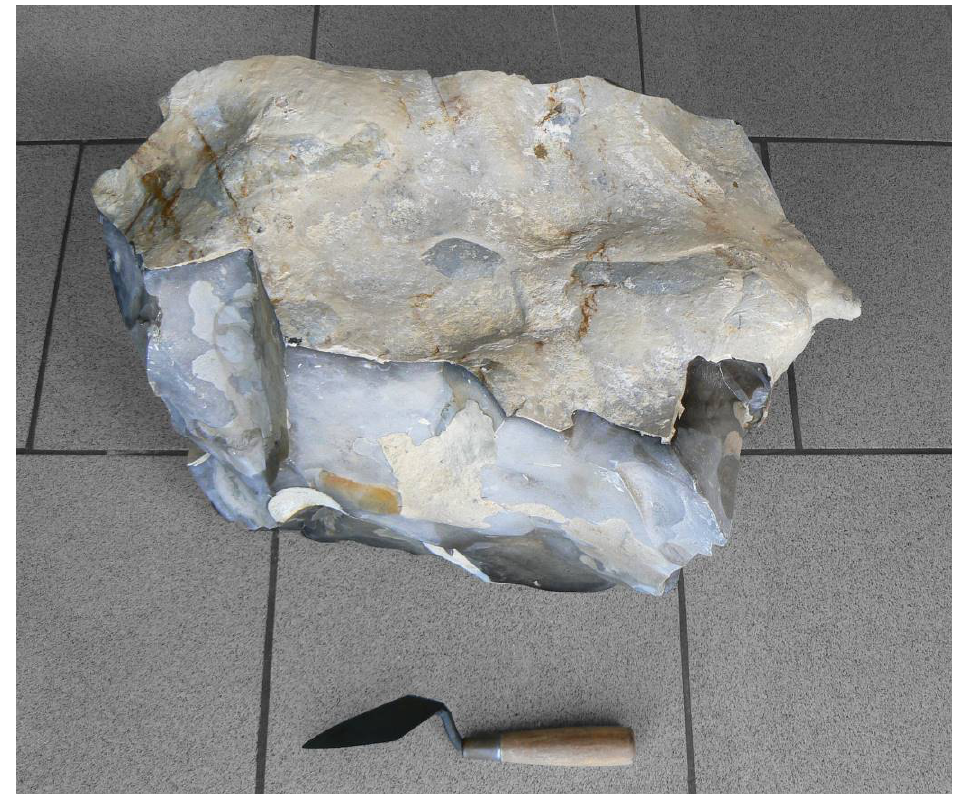
Figure 10. Spiennes. Fragment of a slab abandoned in the 16m deep shafts excavated between 1912 and 1914. Photo by M. Woodbury,